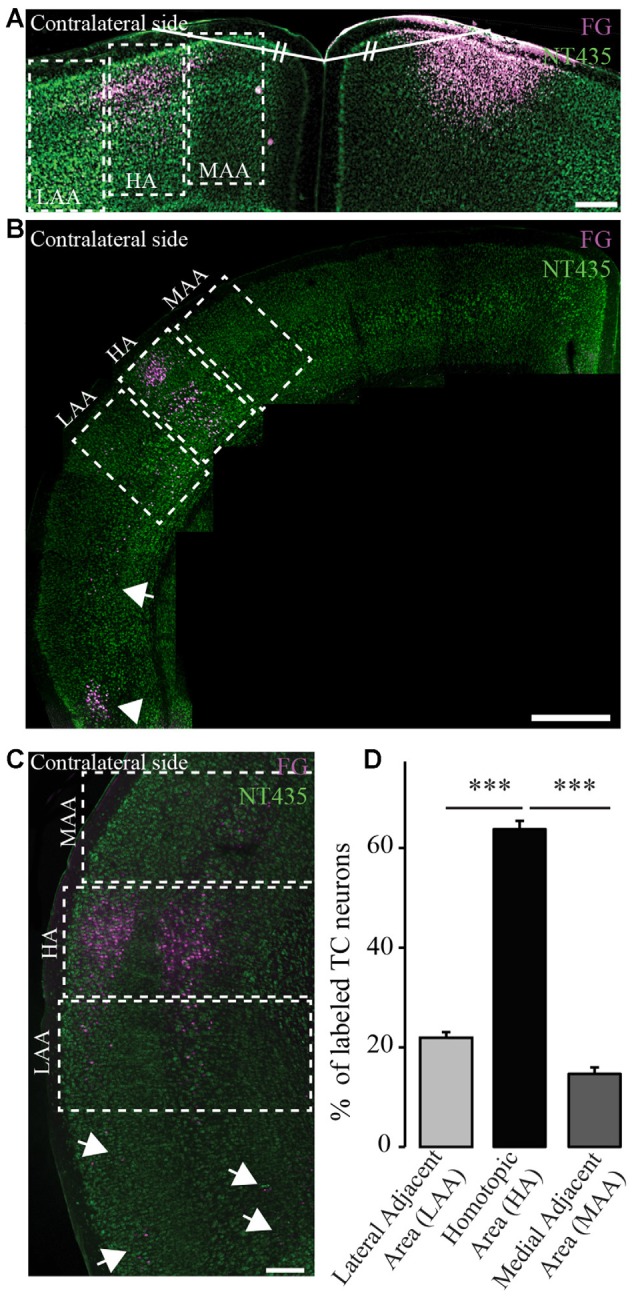
Homotopic organization of transcallosal projection neurons.
(A) Confocal image of retrogradely labeled transcallosal projection neurons (injection in the motor cortex rostral to Bregma) that illustrates how we analyzed the homotopic organization of the transcallosal projection neurons. Shortly, a line was drawn from the center of injection of the retrograde tracer and the junction of the two hemispheres. Then a similar line (same length and same angle) was drawn to the contralateral side to define the homotopic area (HA), the lateral adjacent area (LAA) and the medial adjacent area (MAA). (B,C) Confocal pictures showing the organization of transcallosal projection neurons mostly in the area homotopic to the contralateral point of injection after injections in the barrel cortex caudal to Bregma (B,C). The two adjacent areas show the presence of some projection neurons albeit in minor quantities. Some neurons were also found in the lower perirhinal cortex (B, white arrowhead and C, white arrows). (D) Quantification of the repartition of transcallosal projections neurons in the three areas defined in (A). Scale bars equal 200 μm in (A,B) and 500 μm in (C). One-way anova followed by Tukey post hoc test: ***p < 0.001.